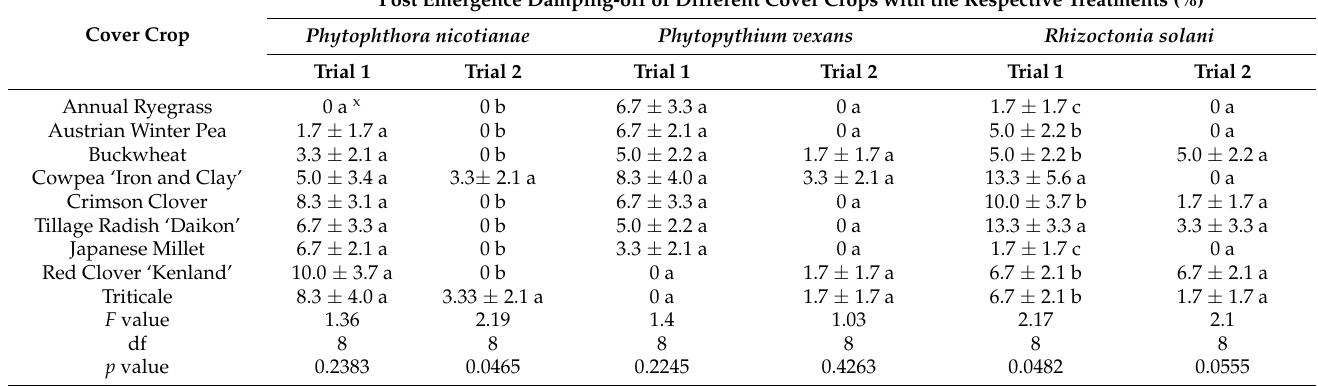
Table 6. Post emergence damping-off of different cover crops with the respective treatments of Phytophthora nicotianae , Phytopythium vexans , Rhizoctonia solani .